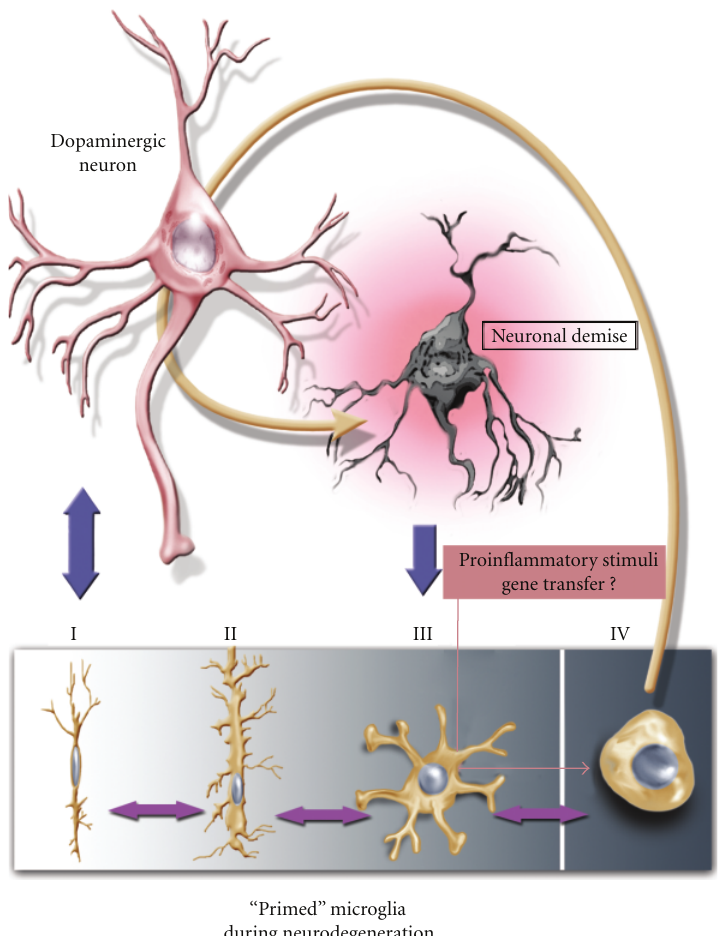
Figure 1: Schematic representation of the interactions between microglial activation and gene transfer. During neuronal death, microglial cells are activated to a “primed” state, where no proinflammatory cytokines are secreted. After receiving an additional (proinflammatory) stimulus, microglia activation changes into an exacerbated proinflammatory state that leads to increased neurodegeneration. Depending on variables such as type and dosage of vector used, inoculation of viral vectors might provide this second proinflammatory